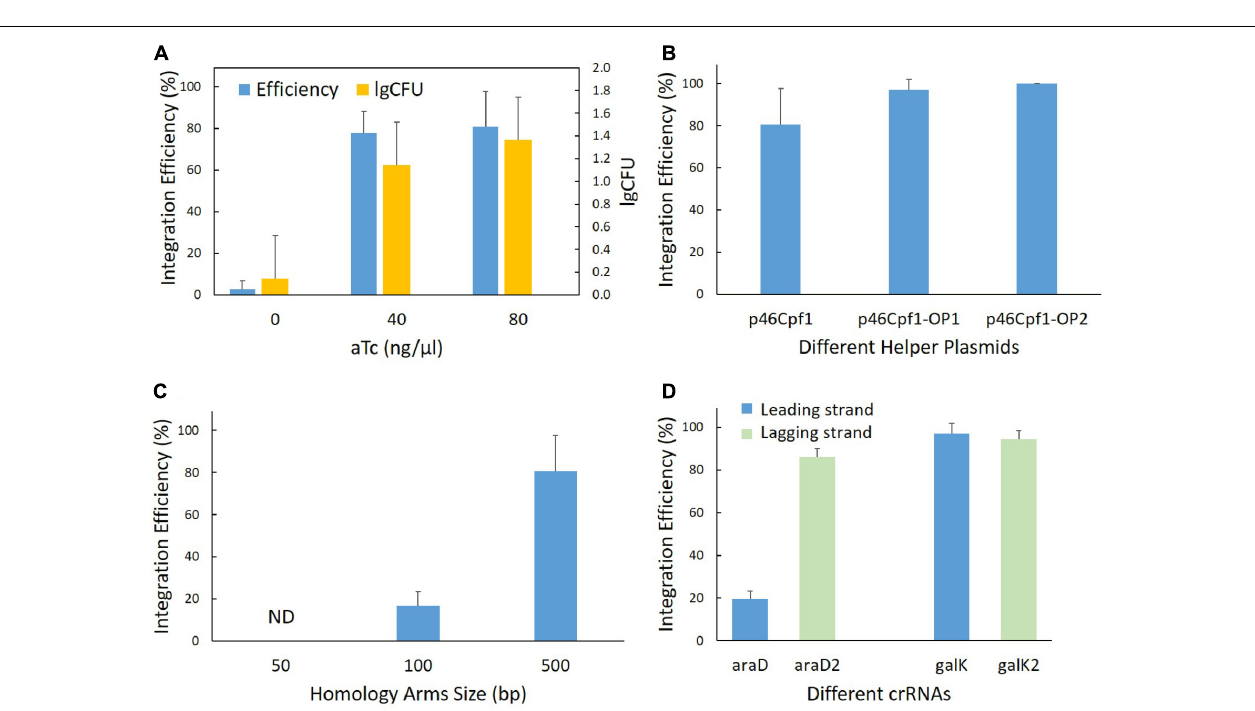
FIGURE 3 | Parameters affecting recombination efficiency. (A) Effect of the λ -Red machinery. Genomic integration was performed at the pyrF site in both the λ -Red induced (aTc added) and non-induced (aTc not added) backgrounds. The helper plasmid p46Cpf1 and the donor plasmid pTc-PG were used. CFU stands for colony number of forming units per microliter of culture. (B) Effect of codon optimization of the Cas12a gene. Genomic integration was performed at the pyrF site using different helper plasmids - p46Cpf1 with the original Cas12a ( Cpf1 ) gene, p46Cpf1-OP1 and p46Cpf1-OP2 with codon optimized Cas12a genes. The donor plasmid pTc-PG was used. (C) Effect of homology arm length on integration efficiency. Genomic integration was performed at the pyrF site with different donor plasmids, pTc-P-50bp providing the donor template with 50-bp homology arms, pTc-P-100bp with 100-bp homology arms and pTc-P with 500-bp homology arms. The helper plasmid p46Cpf1 was used. Modified colonies were not detected when using 50 bp homology arms. ND, not detected. (D) Relationship between integration efficiency and different crRNAs. The crRNAs araD and galK target the leading strand in the E. coli genome, while the crRNAs araD2 and galK2 target the lagging strand. The helper plasmid p46Cpf1 was used. The data represent the averages of three independent